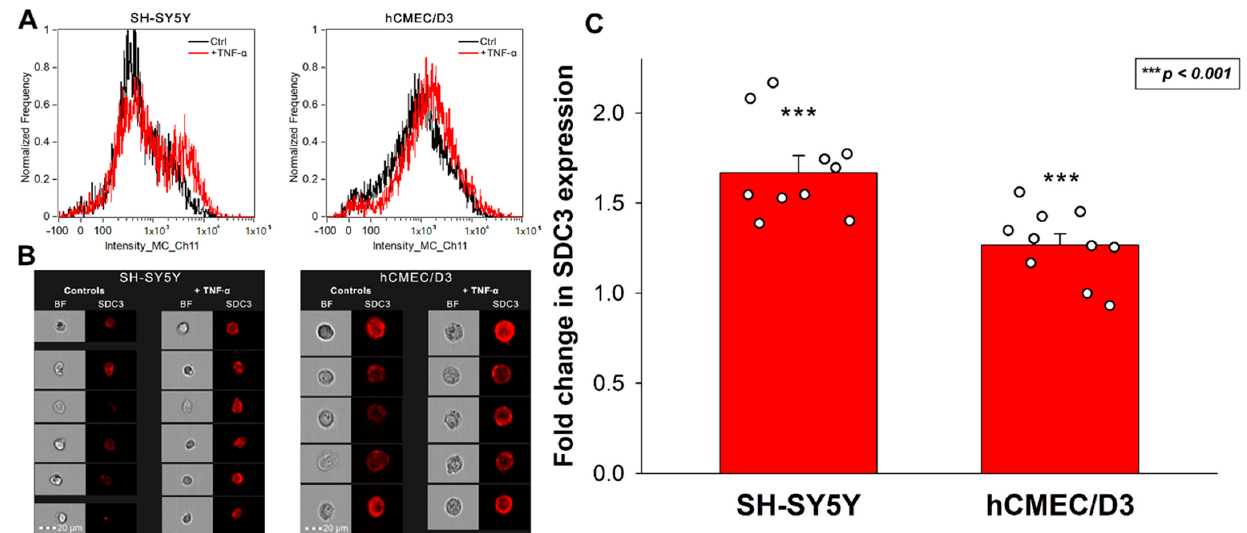
Figure 1. SDC3 expression of TNF- α -treated SH-SY5Y and hCMEC/D3 cells. Cells were incubated with or without (i.e., controls) 5 ng/mL TNF- α for 7 days. After incubation, the cells were treated with APC-labeled SDC3 antibody, and SDC3 was measured with imaging flow cytometry. ( A ) Rep- resentative flow cytometry histograms showing the SDC3 expression of SH-SY5Y and hCMEC/D3 cells. ( B ) Brightfield (BF) and fluorescent cellular images of SH-SY5Y and hCMEC/D3 cells treated with APC-labeled SDC3 antibody. Scale bar = 20 μ m. ( C ) Detected fluorescence intensities were normalized control cells untreated with TNF- α . The bars represent the mean + SEM of ten independ- ent experiments. Statistical significance vs. controls was assessed with ANOVA. *** p < 0.001.